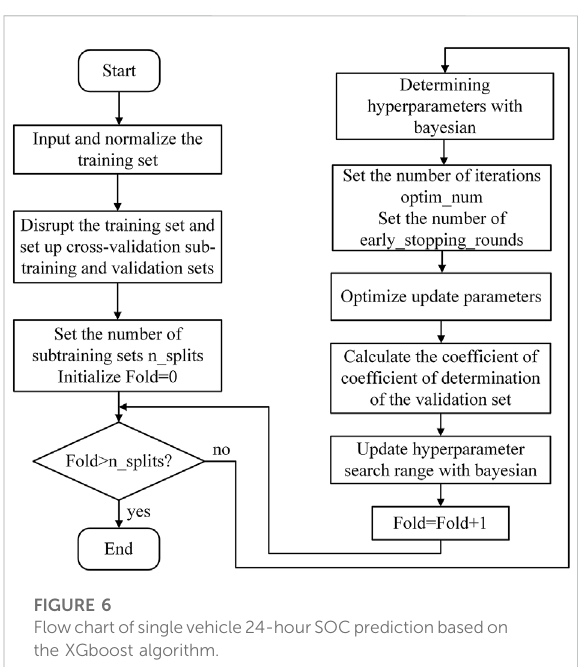
FIGURE 6 Flowchartofsinglevehicle24-hourSOCpredictionbasedon the XGboost